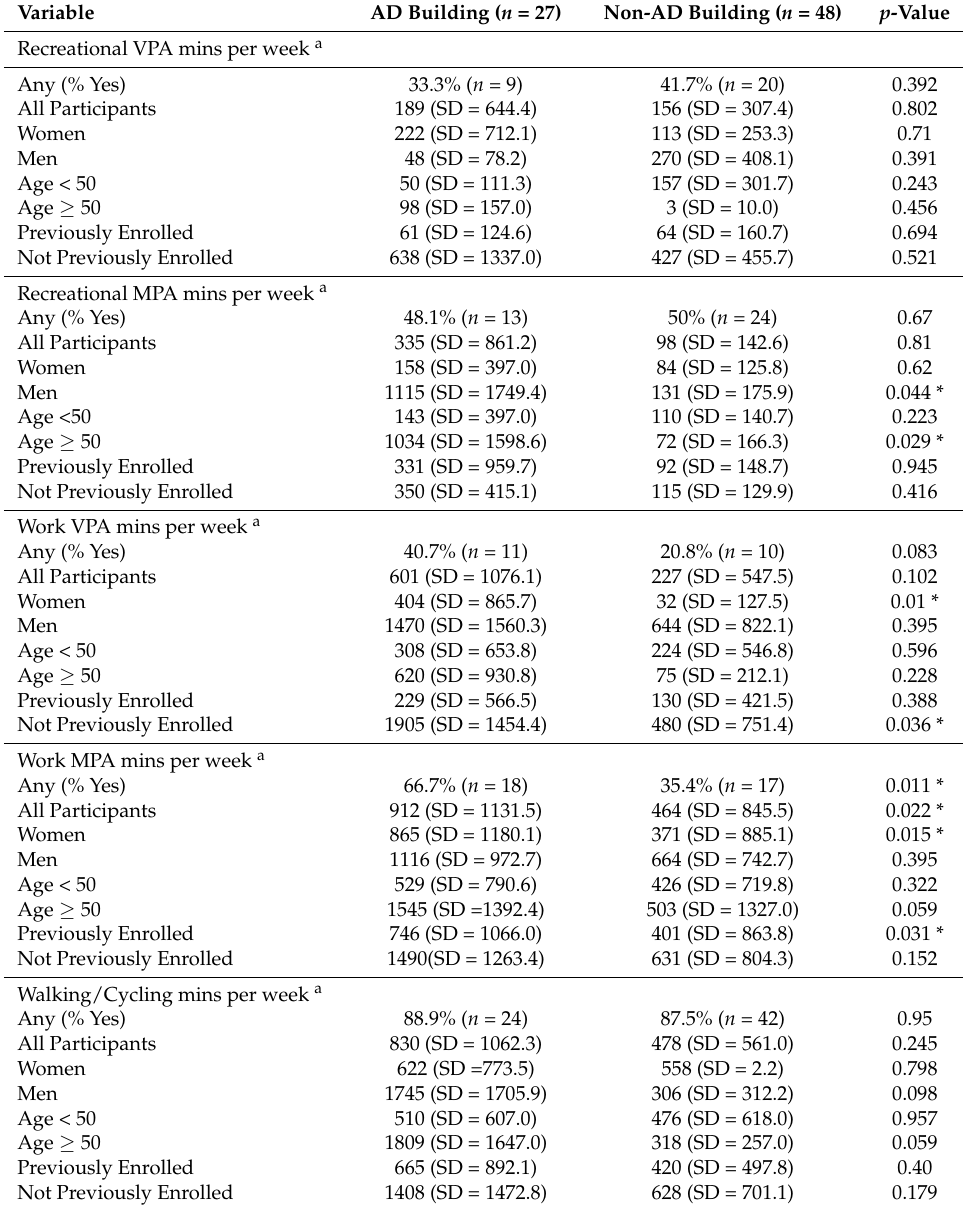
Table 5. Stratified Cross-sectional One Year (T1) Physical Activity Questionnaire Responses.